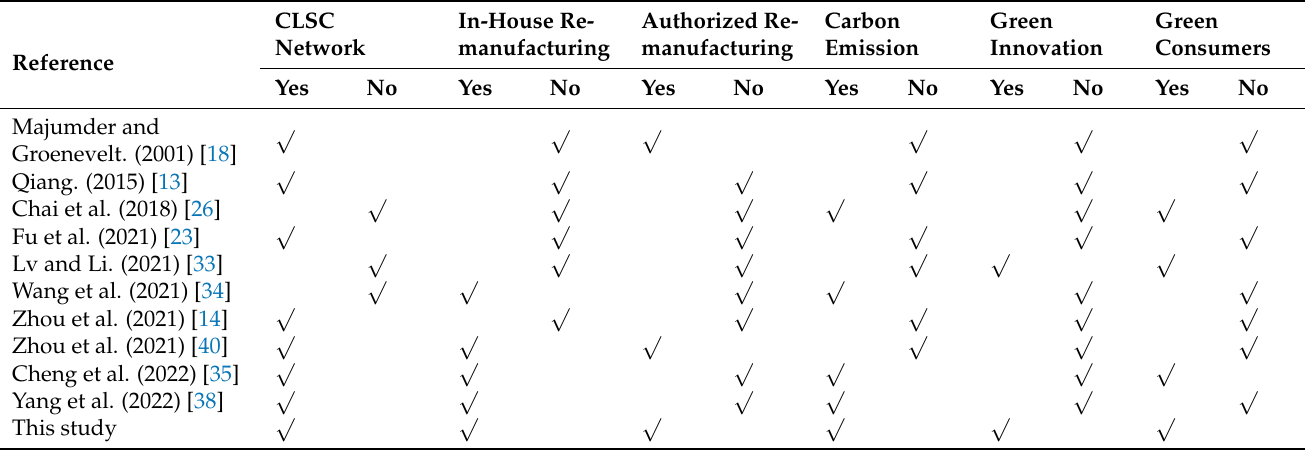
Table 1. The characteristics of this